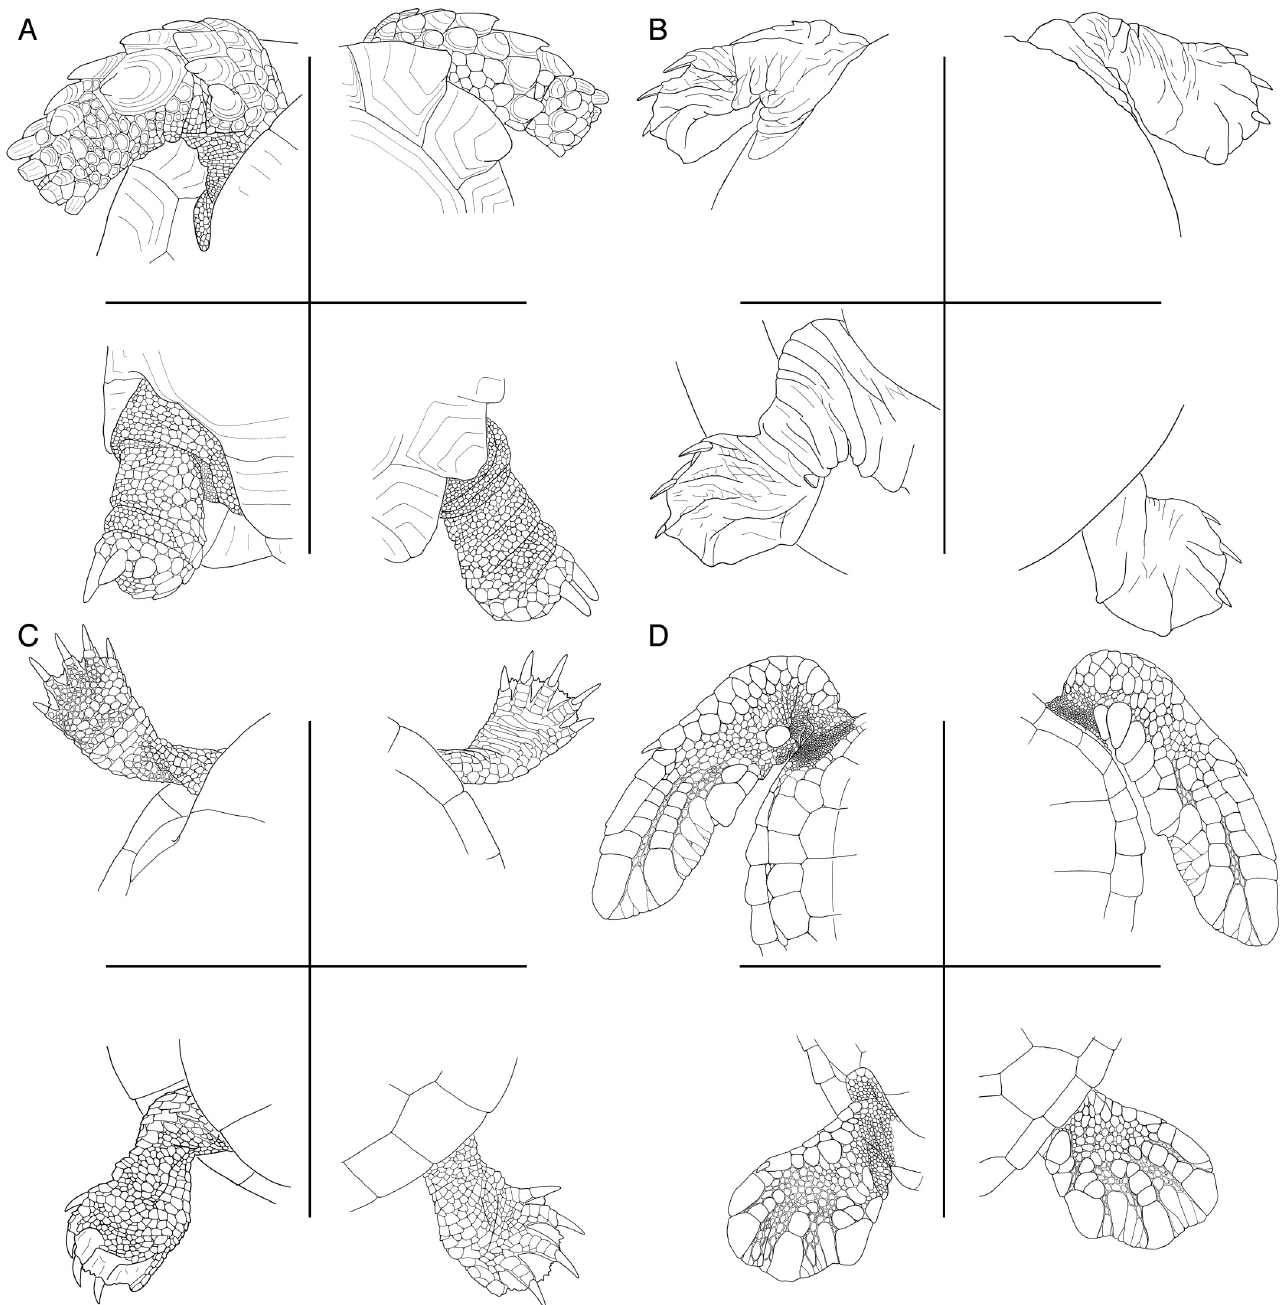
Fig 6. The comparative anatomy of the skin of the limbs of extant turtles. (A) the testudinid tortoise CAS 165598 Psammobates oculifera , an inhabitant of desserts. (B) the trionychid turtle CAS 65705 Apalone spinifera , an inhabitant of rivers. (C) the emydid turtle CAS 13889 Chrysemys picta , an inhabitant of ponds. (D) the cheloniid turtle CAS 8478 Chelonia mydas , an inhabitant of oceans.